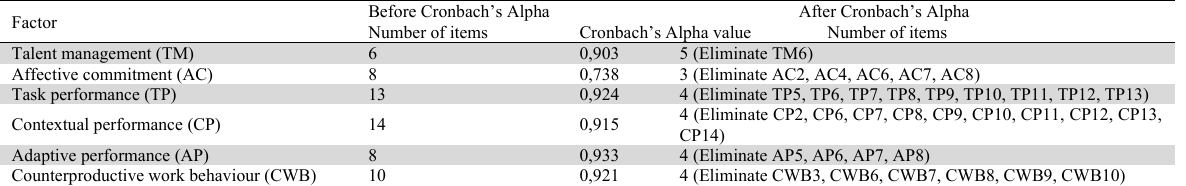
Summary of factors after using Cronbach’s Alpha